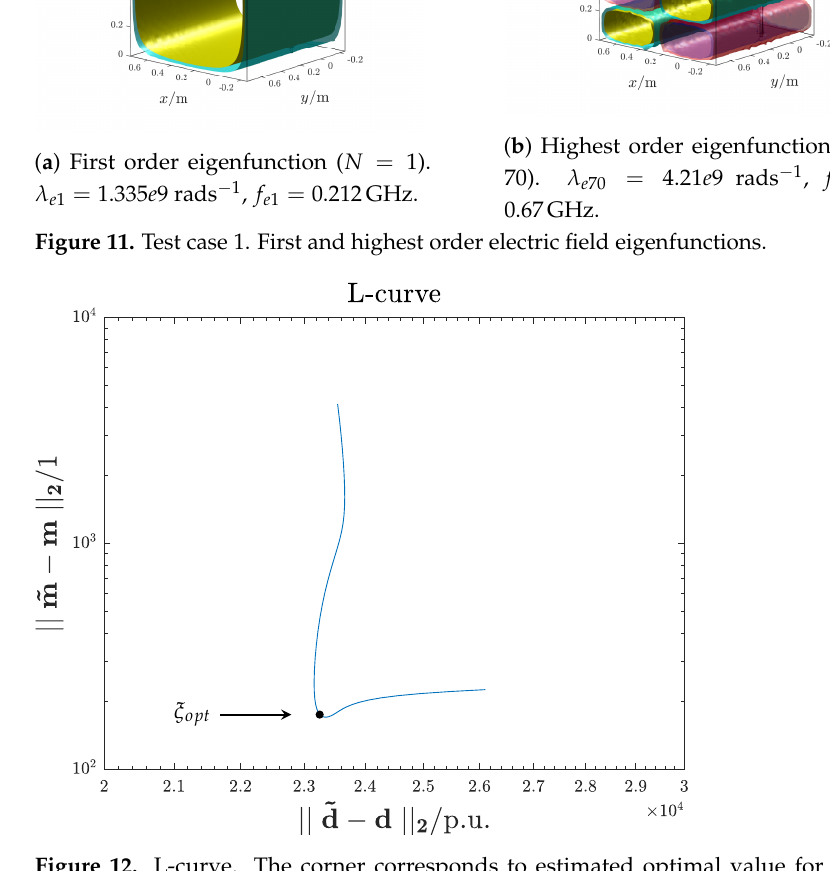
Figure 12. L-curve. The corner corresponds to estimated optimal value for the regularization parameter ξ opt =